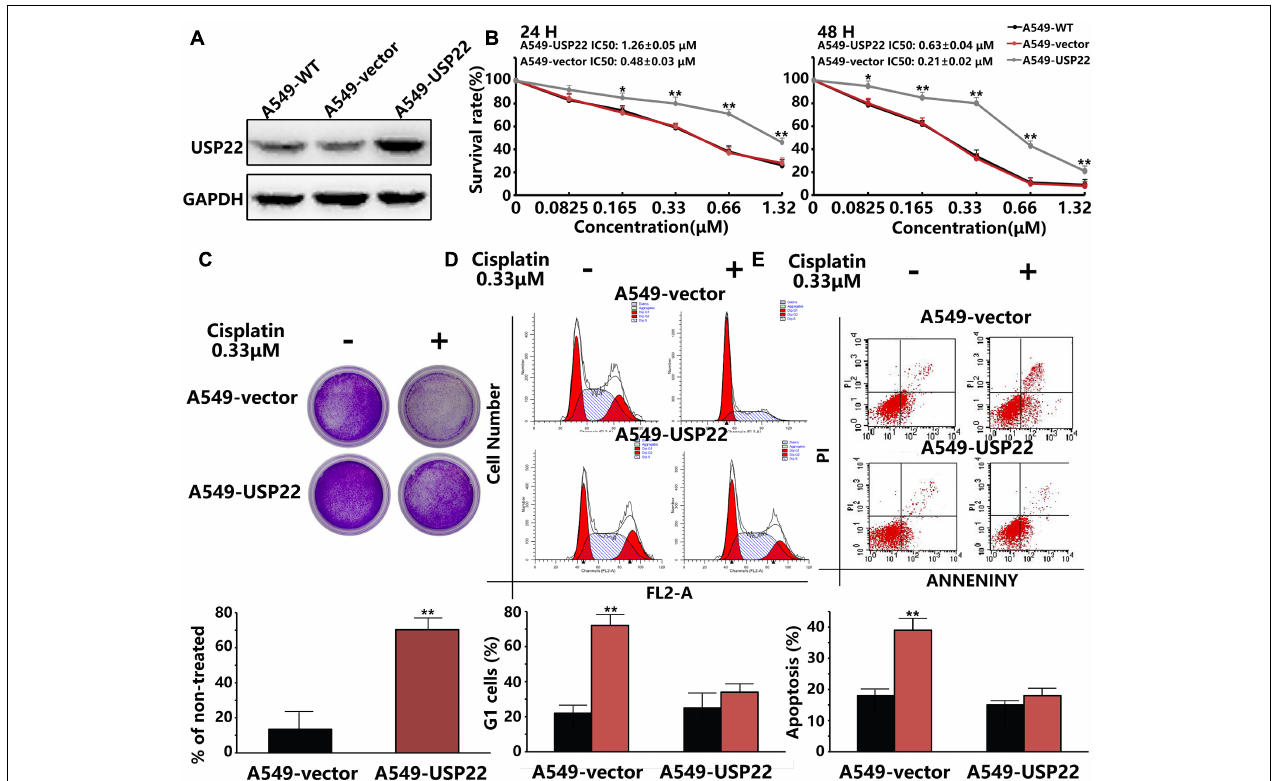
FIGURE 1 | Overexpression of USP22 was correlated with acquired resistance to cisplatin in A549 cells. (A) Western blot analysis of USP22 expression in A549-WT, A549-vector, and A549-USP22 cells (the cell clones which were stably transfected with vector or USP22 overexpression plasmids). (B) The sensitivity to cisplatin of A549-WT, A549-vector, and A549-USP22 cells was detected by CCK-8. Cells were exposed to various concentrations of cisplatin for 24 and 48 h. (C) The response of A549-vector and A549-USP22 cells to cisplatin was tested by colony-forming assay. Cell lines were treated continuously with either 0 or 0.33 µ M of cisplatin for 14 days. (D) A549-vector and A549-USP22 cells were treated with 0 or 0.33 µ M of cisplatin for 48 h and subjected to flow cytometry analysis of cell cycle distribution. Percentage change in G1 phase is shown. (E) Cisplatin-induced apoptosis in A549-vector and A549-USP22 cells was demonstrated by flow cytometric analysis. Cell lines were treated continuously with either 0 or 0.33 µ M cisplatin for 48 h. Every experiment was conducted at least three times, and the average is shown (mean ± SD). ∗ P < 0.05, ∗∗ P < 0.01,